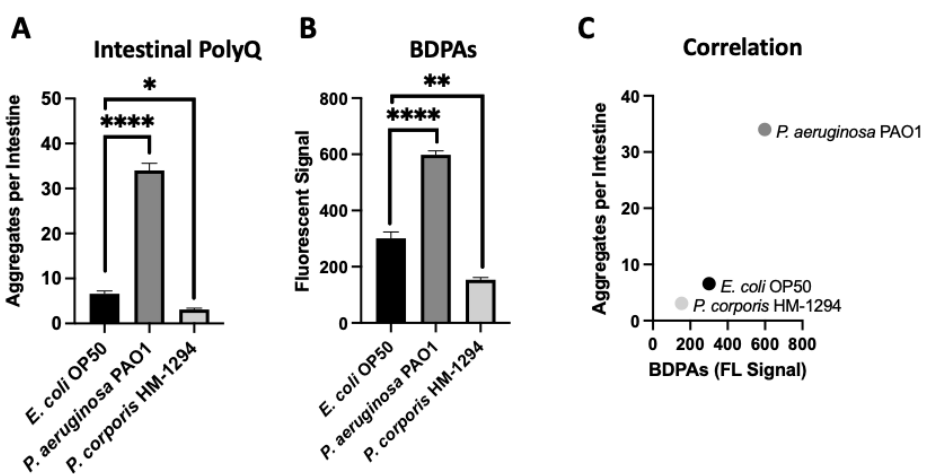
Figure 1. The extent of polyQ aggregation in the C. elegans gut upon bacterial colonization correlates with the relative abundance of BDPAs. ( A ) The effect of P. aeruginosa PAO1 and P. corporis HM-1294 colonization of the C. elegans intestine on polyQ aggregation. Data are represented as the average number of polyQ aggregates per C. elegans intestine. Each data point is an average of three inde- pendent experiments with a total of 60 worms. ( B ) ProteoStat assay quantification of total protein aggregates produced by E. coli OP50, P. aeruginosa PAO1, and P. corporis HM-1294. Data are repre- sented as the average fluorescent signal per bacterial strain stained with ProteoStat. Each data point is an average of two independent experiments with three internal replicates per run. ( C ) A positive correlation between the average number of polyQ aggregates and BDPAs. Error bars represent standard error of the mean (SEM). Statistical significance was calculated using one-way analysis of variance (ANOVA) followed by multiple comparison Dunnett’s post-hoc test (* p < 0.05, ** p < 0.01, **** p < 0.0001).